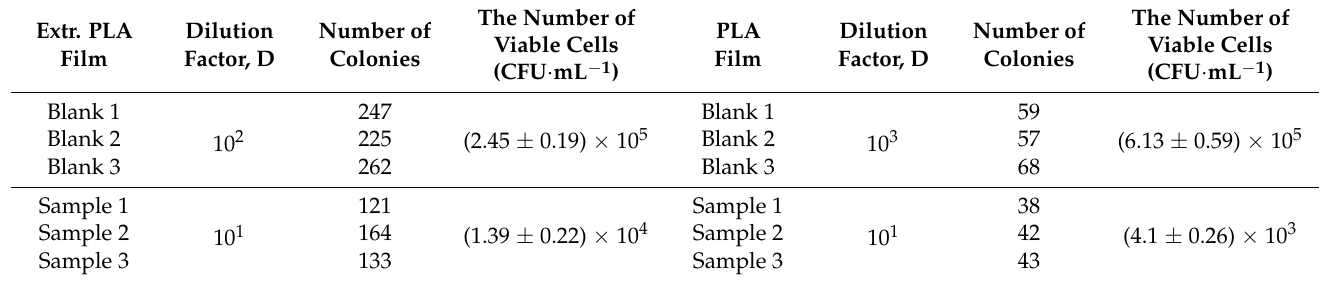
Table 6. The results of E. coli CFU counting after inoculation of blank PLA films and Cu(II)-containing POM/PLA films.